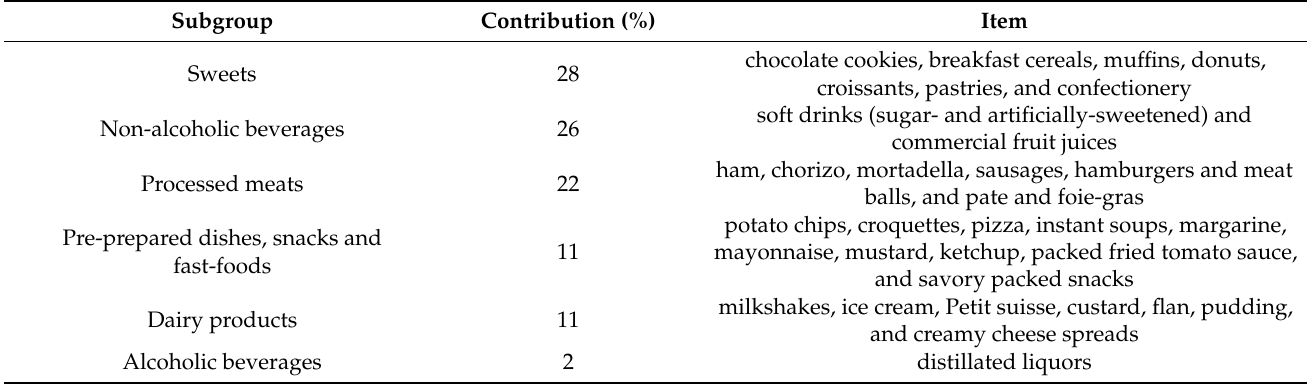
Table 1. Relative contribution of different food groups to the consumption of UPF in diet of partici- pants at